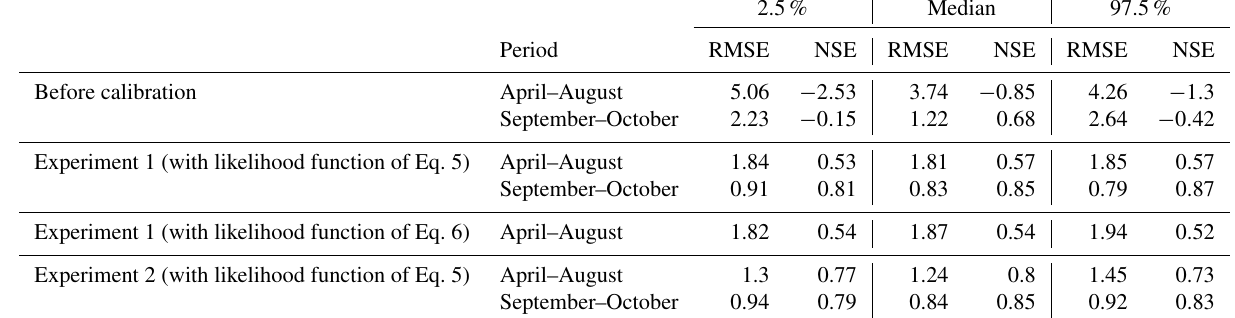
Table 3. Root mean square error (RMSE) and Nash–Sutcliffe efficiency (NSE) between the prior (before calibration)/posterior GPP and flux tower GPP for different experiments (see Sect. 3.3.4) and likelihoods (see Sect. 3.3.2).